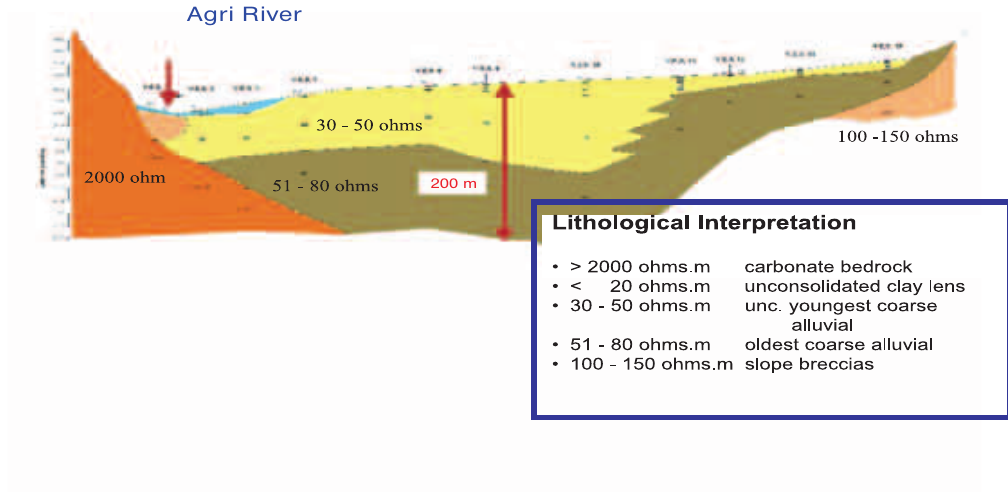
Fig. 11. HR resistivity versus lithology.